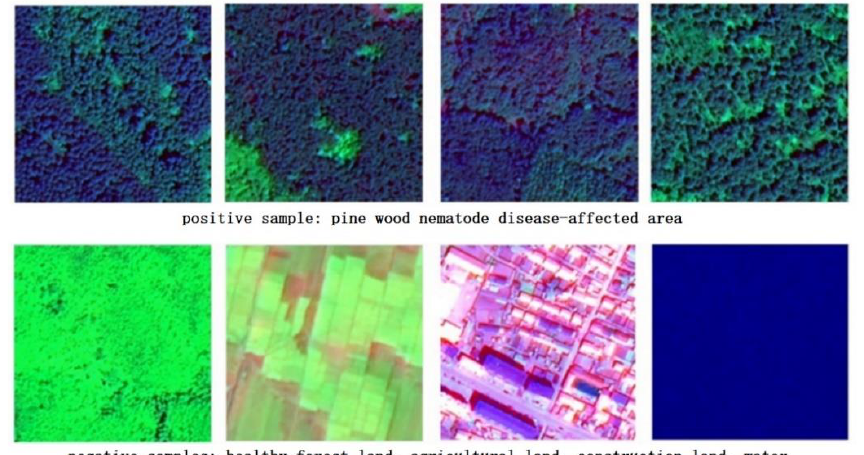
Figure 3. Examples of the samples. The first row shows images of a pine wood nematode disease- affected area. In the second row, from left to right, are images of healthy forestland, agricultural land, construction land, and